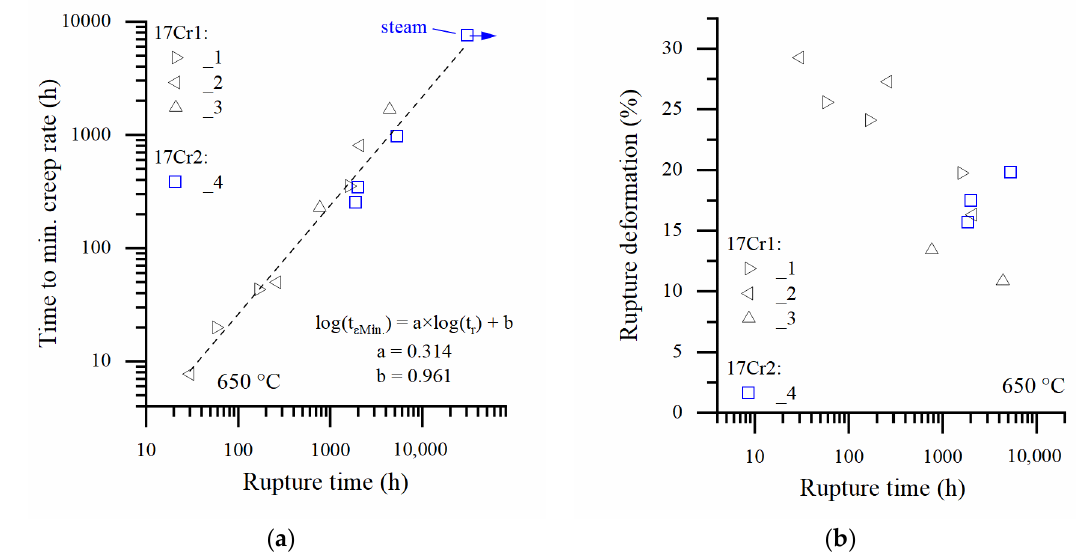
Figure 6. Summary of 650 °C creep properties: ( a ) minimum creep rate vs. rupture time, and ( b ) rupture deformation vs. rupture time (arrows indicate experiments in progress; data excluded from fitting).